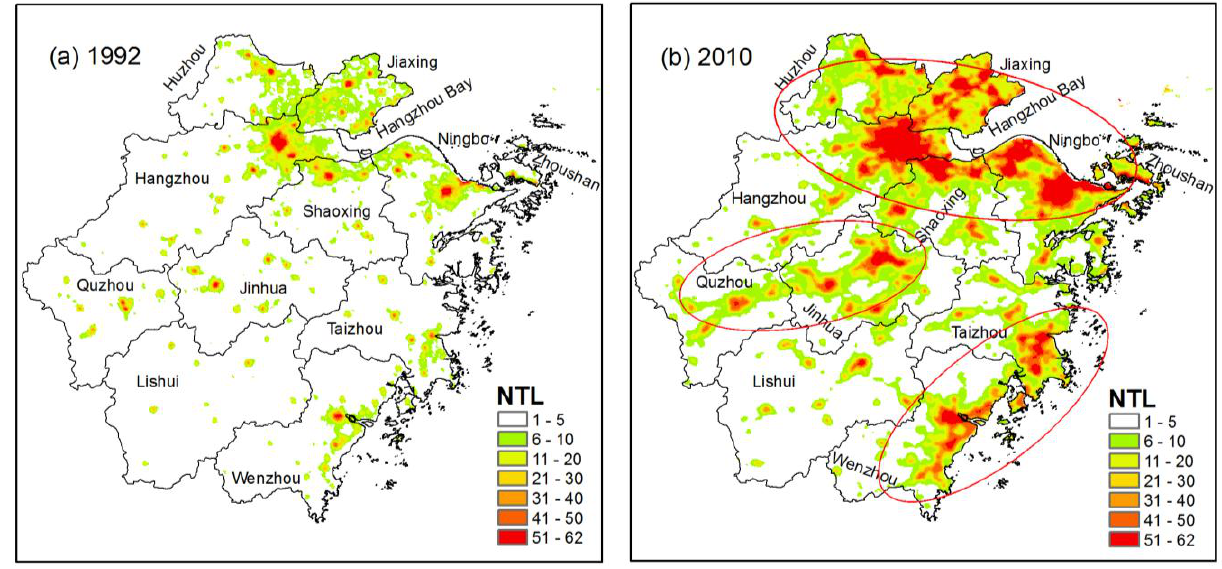
Figure 3. Extent of urban areas in ZJP from ( a ) 1992 to ( b ) 2010 based on inter-calibrated DMSP/OLS nighttime light. Three ellipses indicate three urban clusters (around Hangzhou Bay, the coastal areas of Wenzhou-Taizhou, and the Jinhua-Quzhou